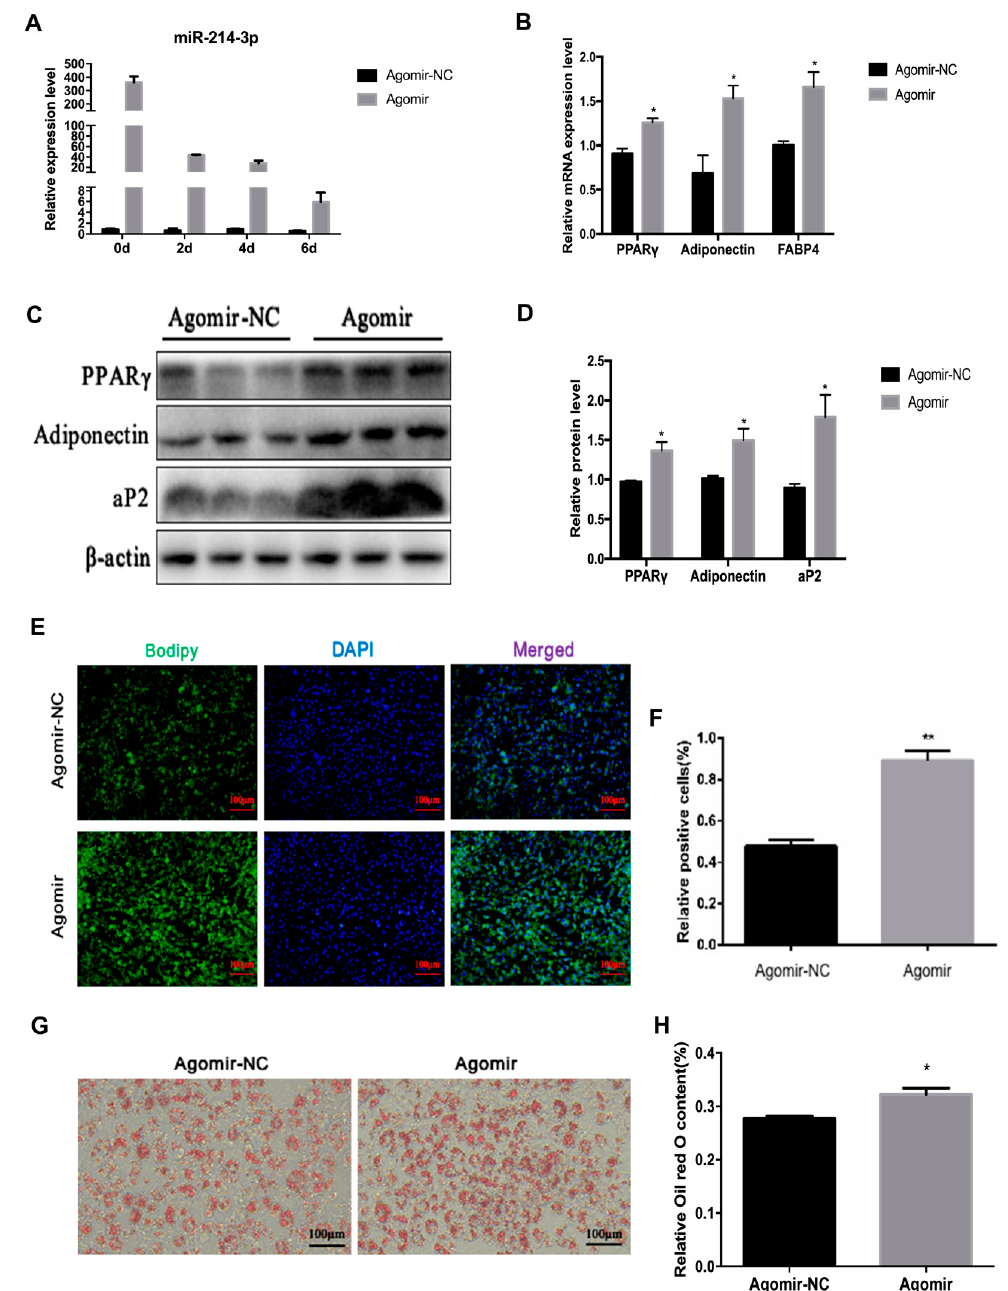
Figure 5. MiR-214-3p enhances adipocytes di ff erentiation in 3T3-L1 cells. MiR-214-3p agomir or negative control (NC) were transfected into cells at 80% density at 50 nM. ( A ) The overexpression e ffi ciency of miR-214-3p after transfection with the miR-214-3p agomir; ( B ) RT-qPCR was used to detect adipogenesis genes, PPAR γ , FAS, Adiponectin, and FABP4 on the sixth day after induction; ( C ) Western blot analysis of adipogenesis genes on the sixth day of di ff erentiation; ( D ) Quantification of Western blot analysis of PPAR γ , Adiponectin, aP2, ( E ) BODIPY staining was performed in cells on the sixth day of di ff erentiation, the lipid droplets of the cells were stained with BODIPY (green) and the total nuclei were stained with 4 (cid:48) ,6-diamidino-2-phenylindole (DAPI) (blue), after transfection with the miR-214-3p agomir; ( F ) BODIPY positive cells / DAPI cells percentage was quantified, (bar size = 100 µ m); ( G ) Oil Red O staining, di ff erentiated 3T3-L1 cells on the sixth day were stained with Oil Red O; ( H ) Triglycerides content was measured by spectrophotometric analysis at 490 nm. Statistical results are indicated as mean ± SEM, n = 3. * p < 0.05; ** p < 0.01, vs.